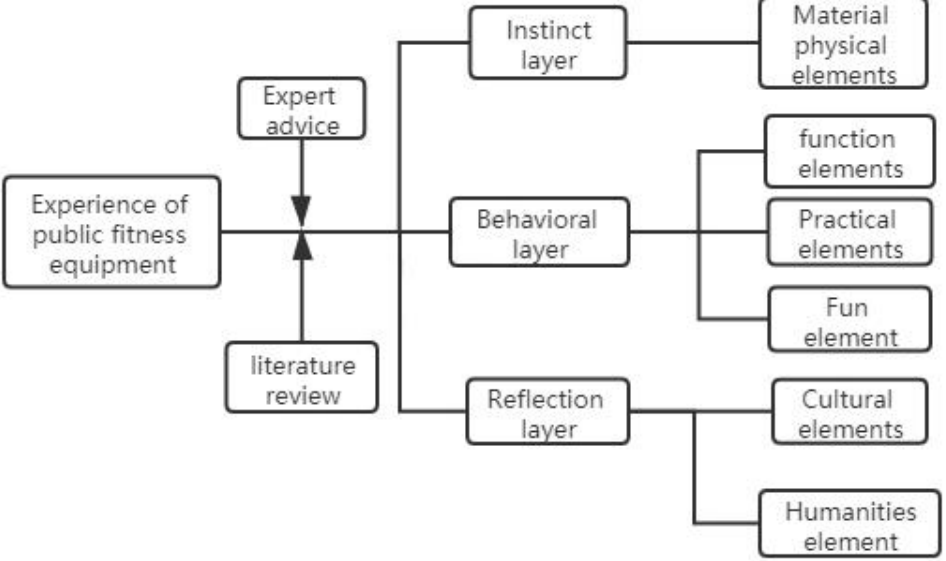
Figure 1. Analysis of the elements of public fitness equipment experience.